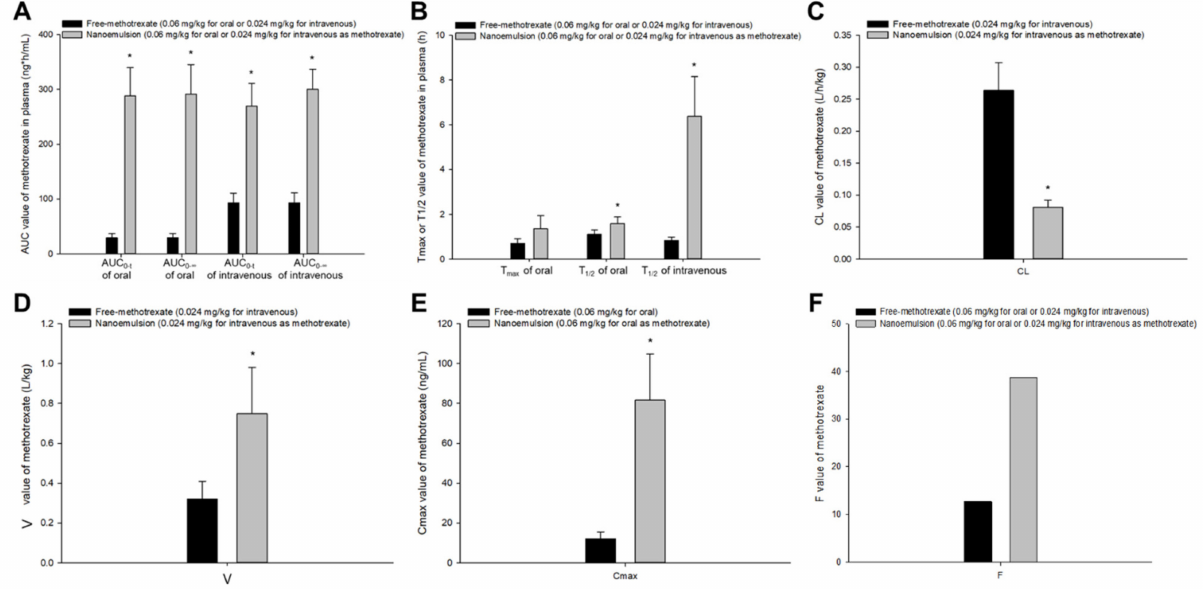
Figure 2. Mean pharmacokinetic parameters ( A ), AUC 0-t and AUC 0- ∞ ; ( B ), T max and T 1/2 ; ( C ), CL; ( D ), V; ( E ), C max ; ( F ), F of methotrexate after oral or intravenous administration of free methotrexate solution (black box, 5 mg/kg) and methotrexate-loaded nanoemulsions (gray box, 0.06 or 0.024 mg/kg as methotrexate) in rats. Vertical bars represent standard deviation of the mean ( n = 5). * p < 0.05 compared with the administration of